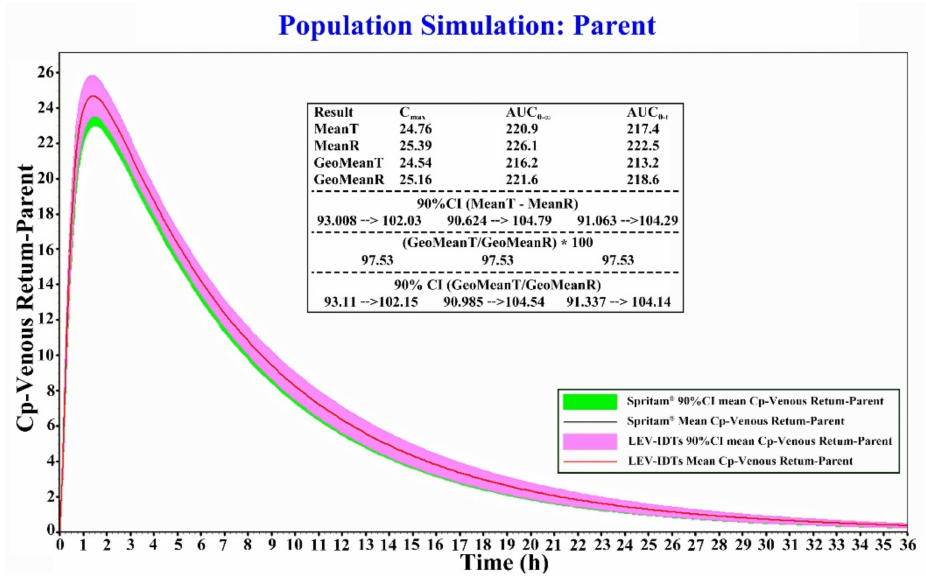
Figure 6. Results of LEV-IDTs and Spritam ® bioequivalence